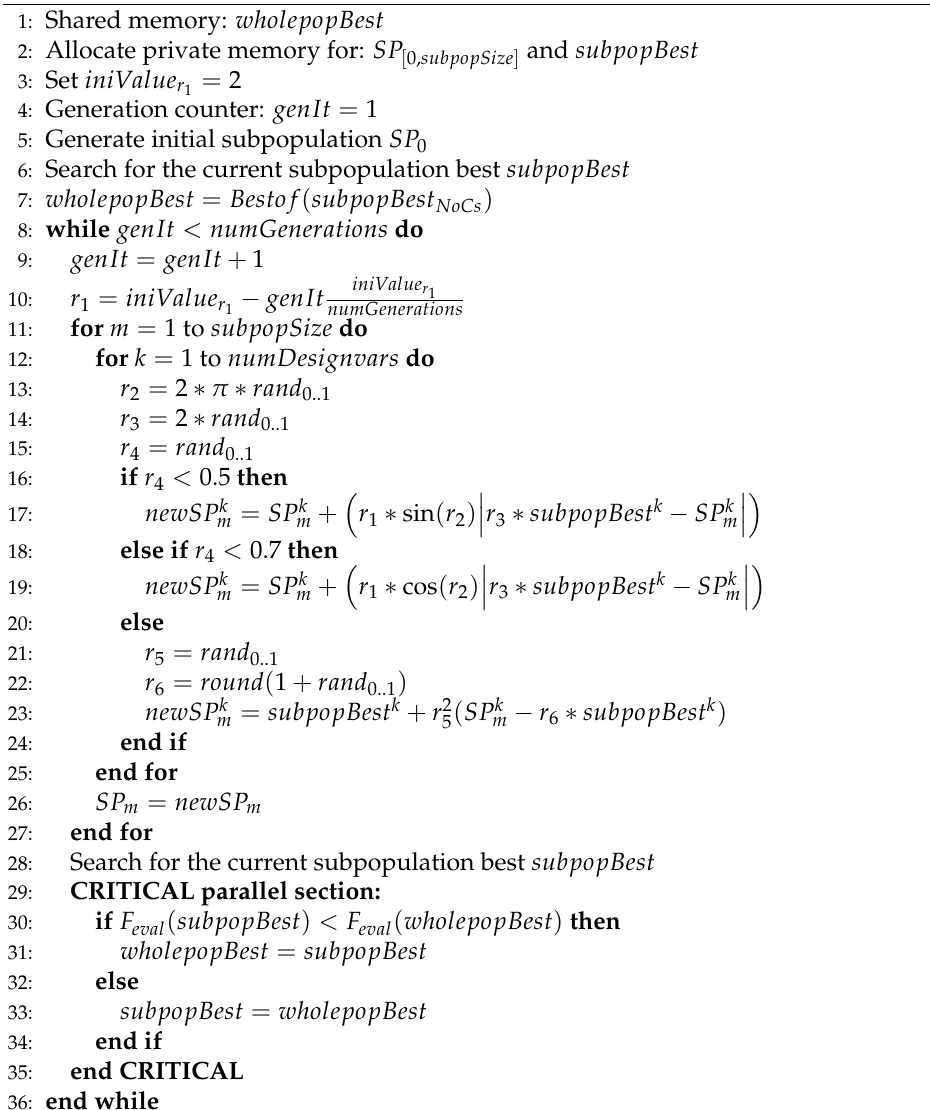
Algorithm 5 Parallel algorithm with data